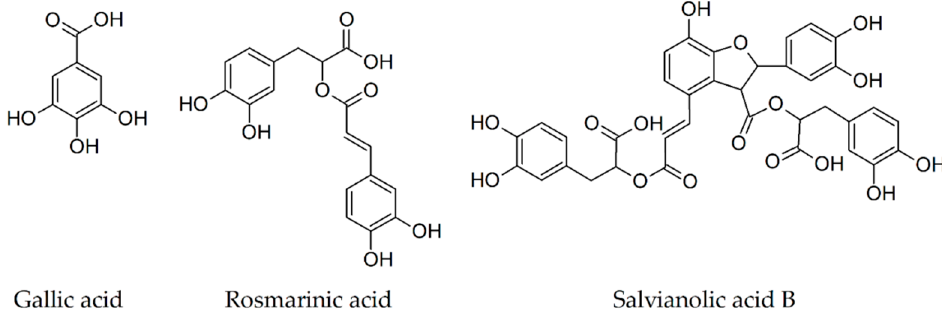
Figure 3. Chemical structures of phenolic acids from plants whose inhibitory activity towards beta- amyloid fibrillogenesis was